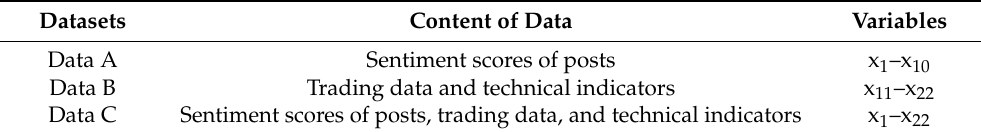
Table 5. Three datasets used in this